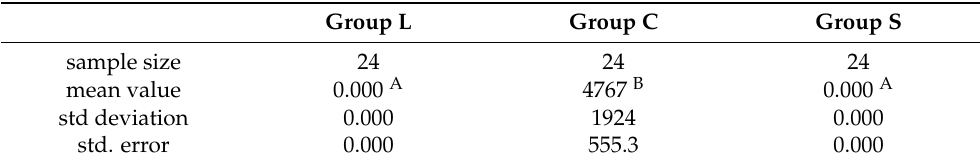
Figure 5. Visual appearance of a titanium disc immediately at the end of the irradiation protocol. This disc had been contaminated and treated by the Q-Switch Nd: YAG laser (Group L). Table 1. Mean with standard deviation of the TBC of microbiological assessments in the three groups. The TBC is expressed in